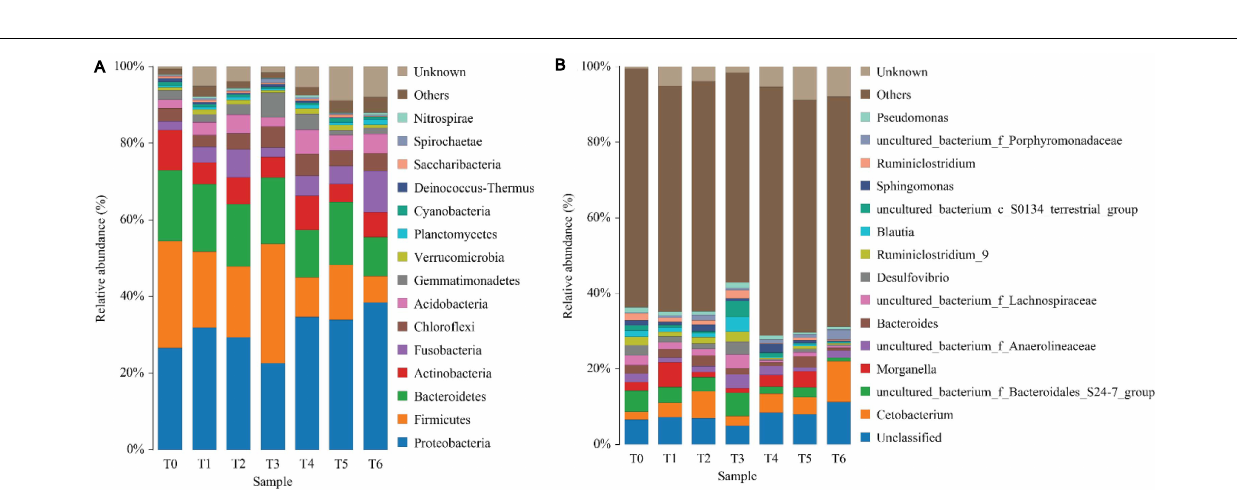
FIGURE 3 | Taxonomy classification of reads from 16 S rRNA V3–V4 regions at the phylum (A) and genus (B) taxonomic levels in intestinal microbiota of grouper E. coioides at day 56. Only top 15 most abundant (based on relative abundance) bacteria phylum and genus were exhibited in (A,B) , and other phylum and genus were all classified as